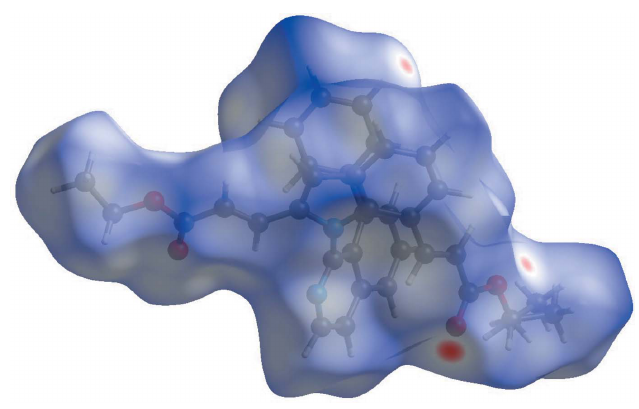
Figure 4 Hirshfeld surfaces of the title compound mapped over d norm .